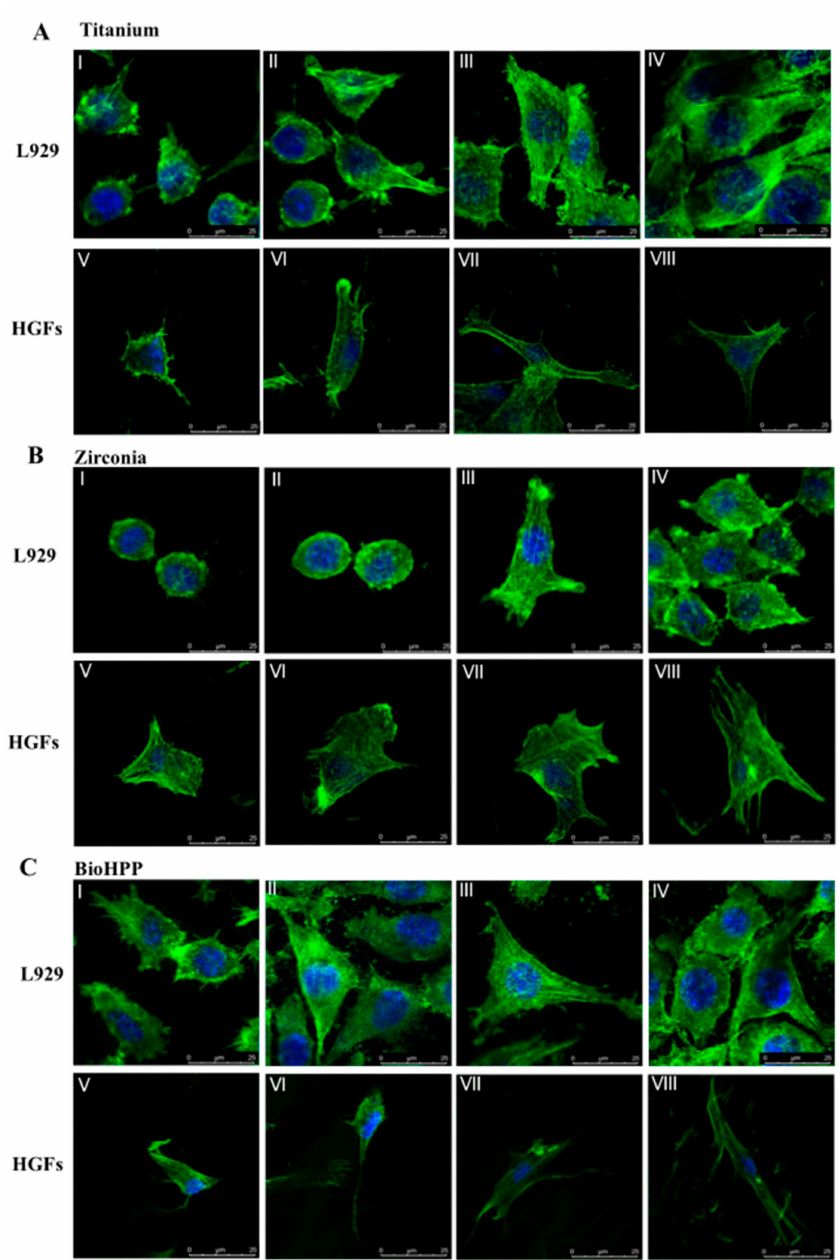
Figure 1. Cell attachment and morphology on di ff erent, surface-treated titanium, zirconia and BioHPP after 24 h. Representative examples of cytoskeleton stained with phalloidin after 24 h of incubation on controls ( I , V ), argon plasma treated ( II , VI ), oxygen plasma treated ( III , VII ) and UV light treated ( IV , VIII )surfaces oftitanium ( A ),zirconia( B )and BioHPP( C )using confocalmicroscopy. Both L929and human gingival fibroblasts (HGFs) increased in volume and adhered flatly to the surfaces. Morphology of cells was more extended and cells were larger, especially on oxygen plasma and UV light treated surfaces. In the oxygen plasma and UV light treated groups, L929 and HGFs extended most, and had more filopodia-like cell